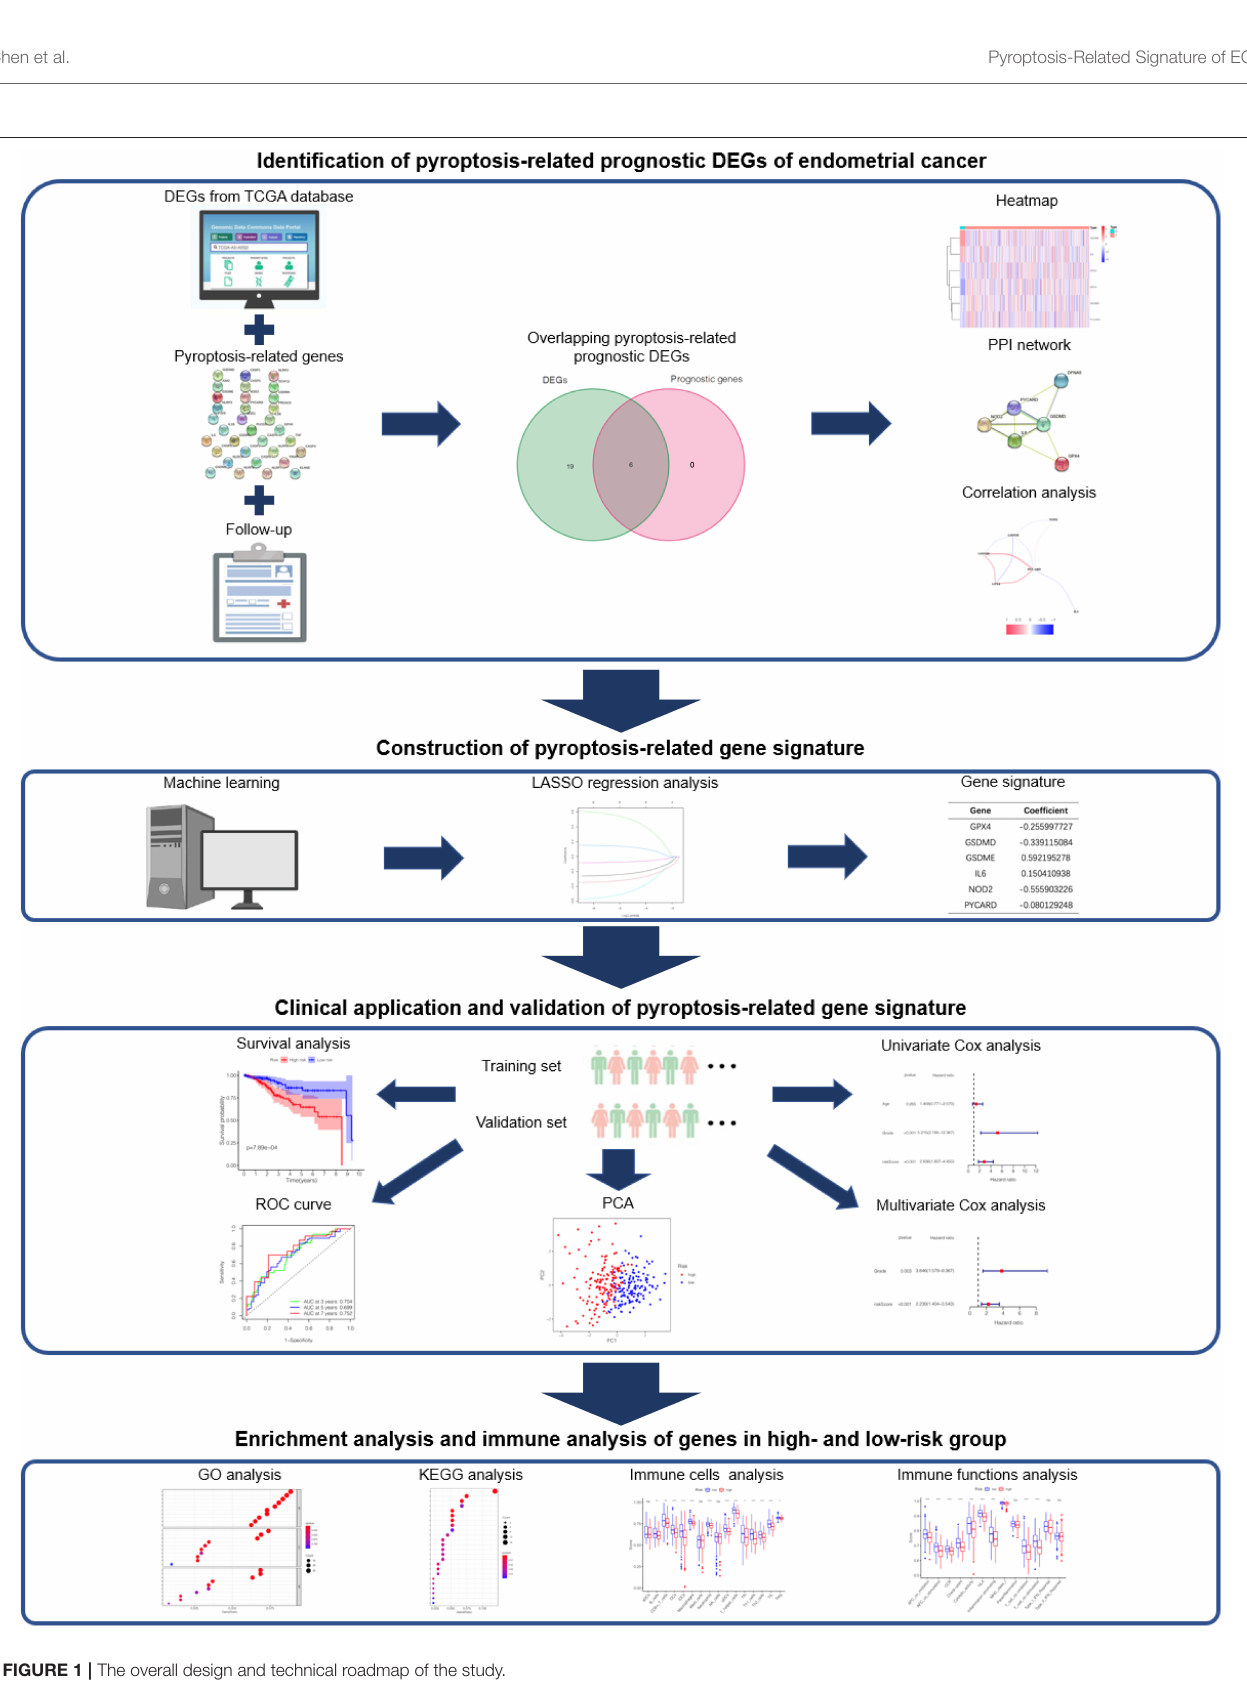
Frontiers in Medicine |